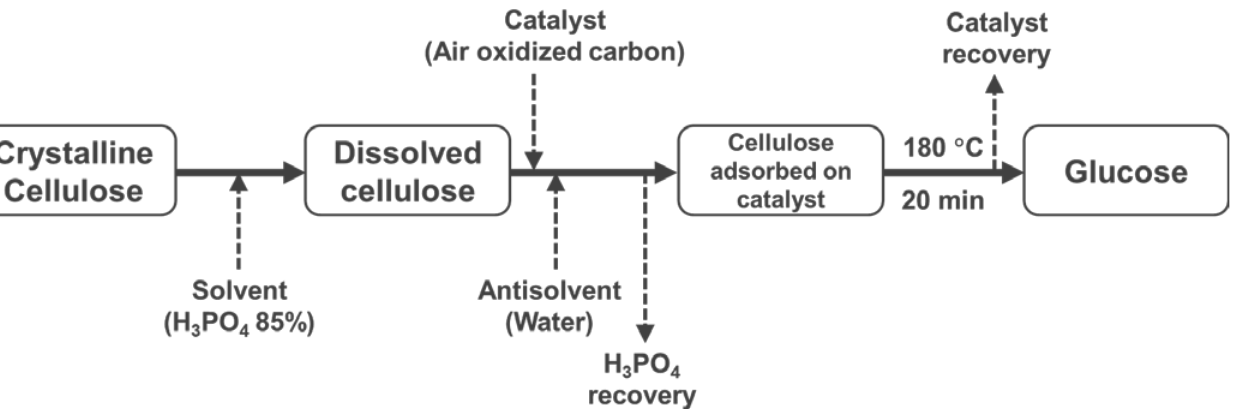
Figure 3. Schematic representation of solvent-assisted adsorption process followed by hydrolysis of adsorbed cellulose to obtain glucose.